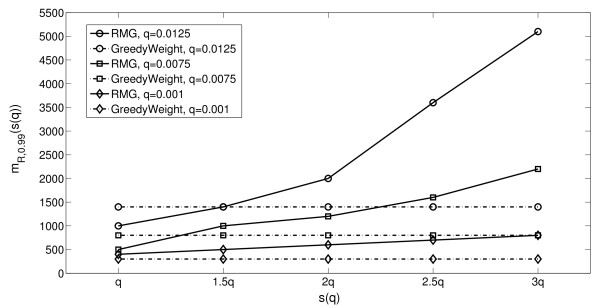
Comparison of Algorithm 1RMG and Algorithm 2 GreedyWeight. Comparison between the estimate of the number of patients mR,0.99(s(q)) required to identify the driver pathway
 with Algorithm 1 RMG, for different estimates s(q) of the probability q and different values of q, and the number of patients mG,0.99required to identify
 with Algorithm 2 GreedyWeight.